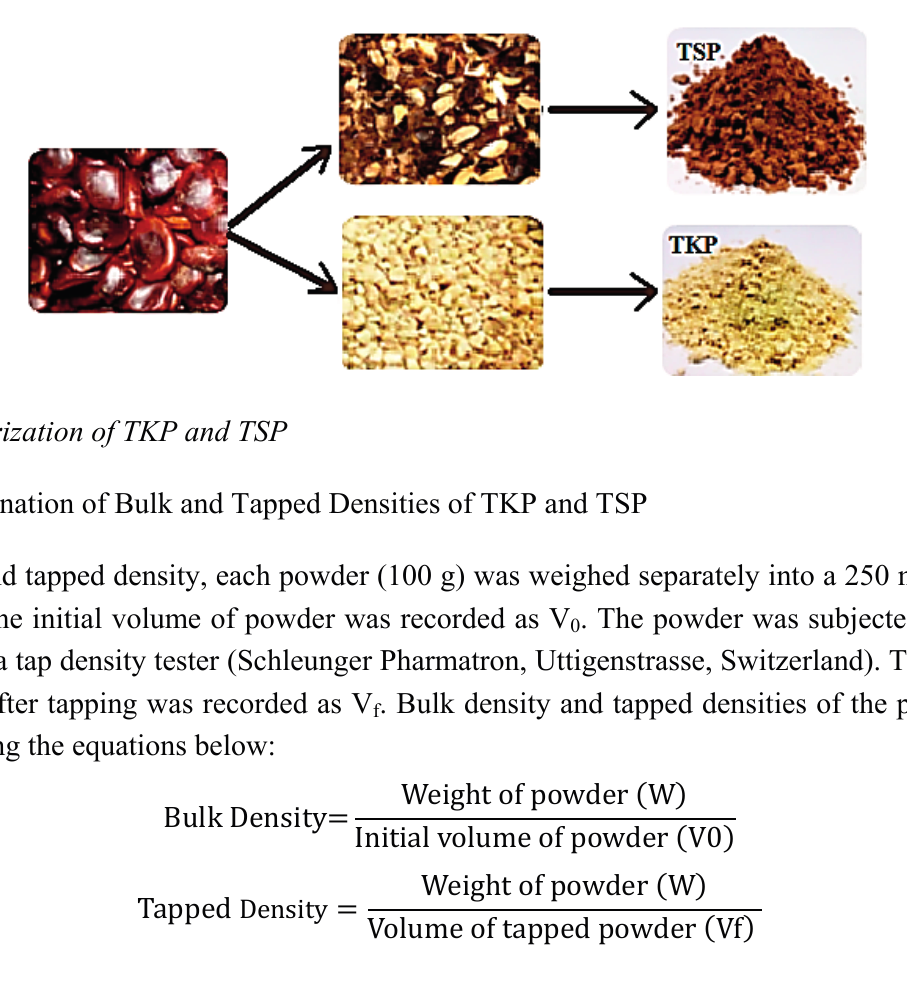
Figure 12. Size reduction of tamarind seeds to TKP and TSP